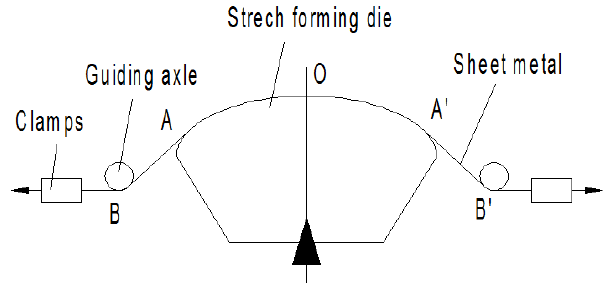
Figure 2. The schematic diagram of stretch-forming die.